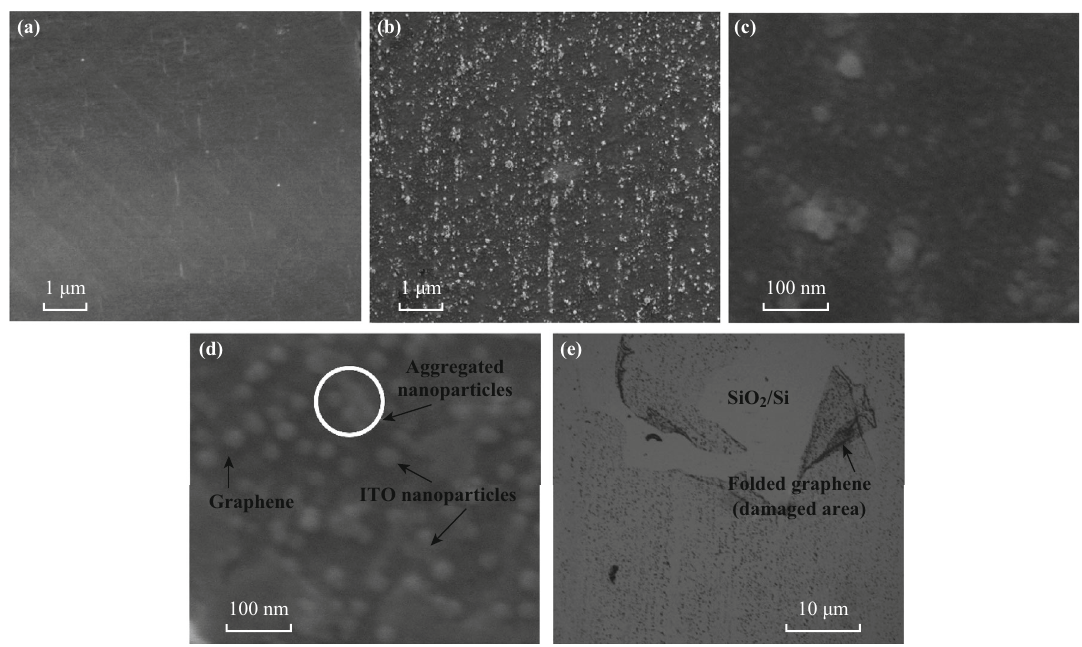
Fig. 2 FE-SEM images of a CVD graphene on copper. b ITO nanoparticle-deposited (1-min immersion of graphene in ITO solution) graphene on copper after air drying. c ITO nanoparticle-deposited graphene on SiO 2 (300 ± 10 nm)/Si substrate before annealing. d ITO nanoparticle- deposited graphene on SiO 2 (300 ± 5 nm)/Si substrate after vacuum annealing at 450 (cid:3) C for 1 h. e Optical microscopic imagery of ITO nanoparticle-decorated graphene on SiO 2 (300 ± 5 nm)/Si substrate after annealing. The black dots represent ITO